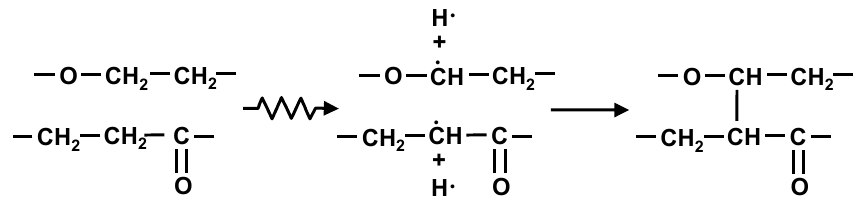
Figure 11. Image of cross-linking reaction of irradiated PLA-80.